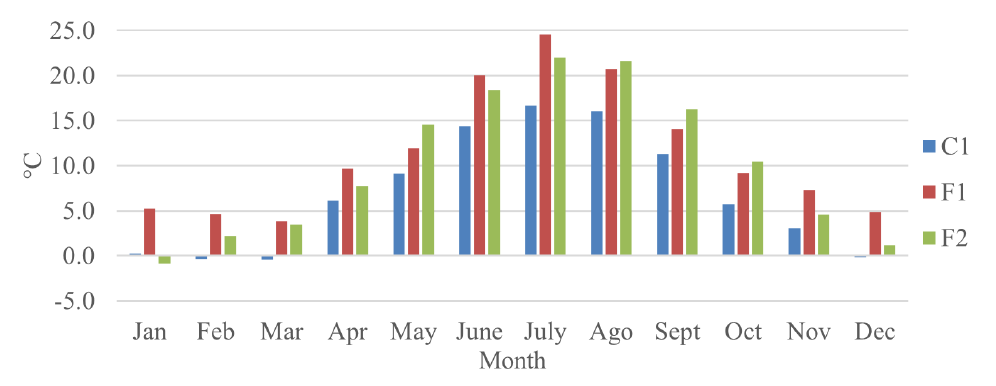
Figure 2. Monthly average daily temperature in Stockholm for the three climate scenarios.